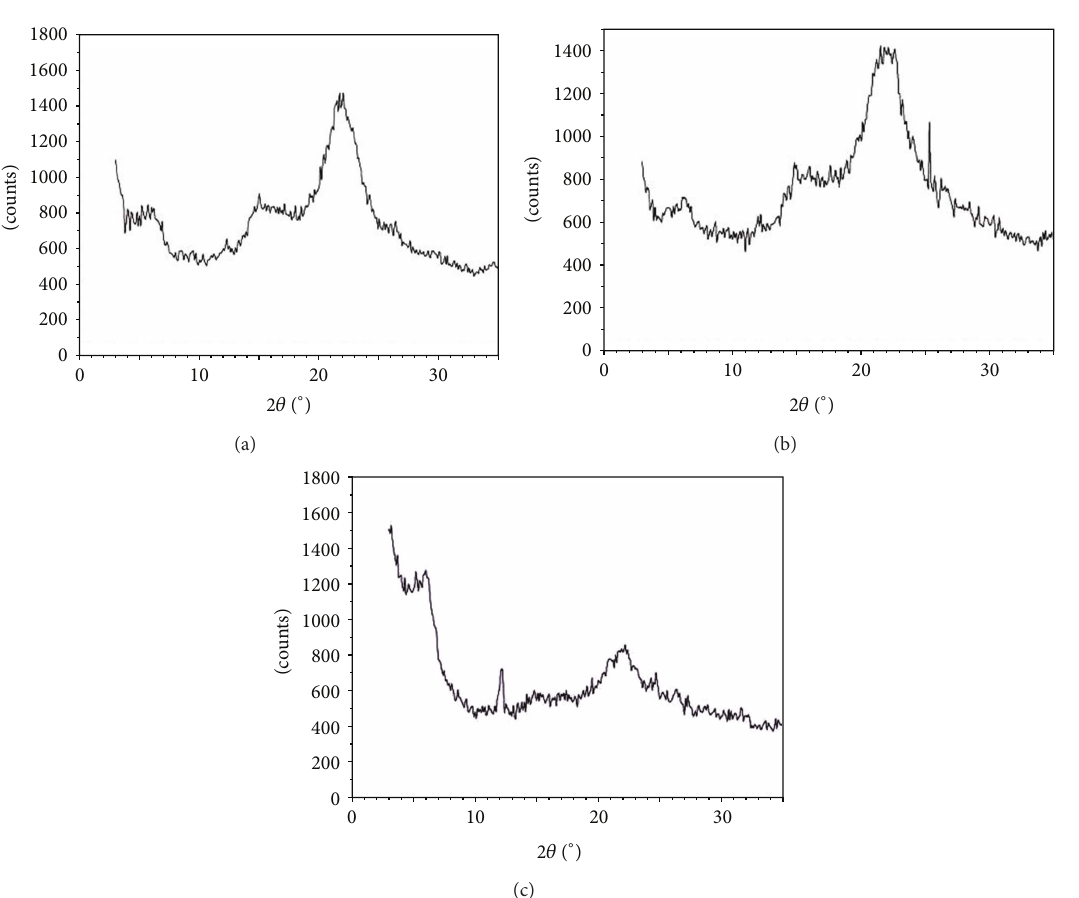
Figure 2: SEM images of (a) untreated sample and (b) sample pretreated with microwave assisted sodium hydroxide (NaOH).